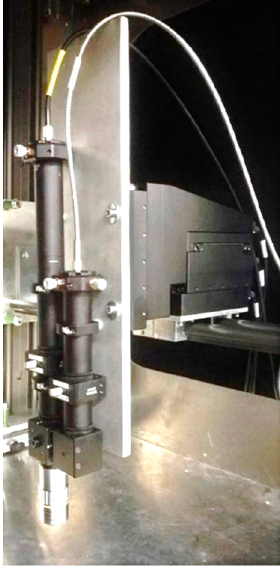
Figure 9. Raman scanning probe with long working distance mounted on a 3D-displaceable table [24].